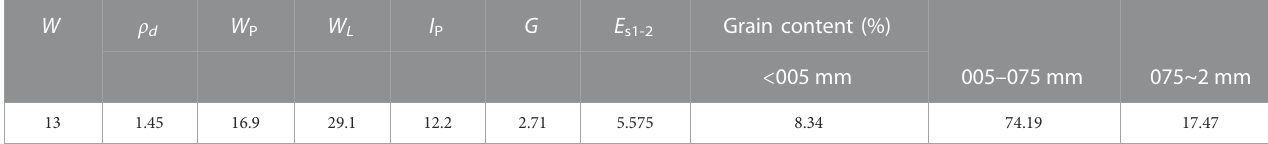
TABLE 1 Physical and mechanical parameters of the Undisturbed loess in the natural